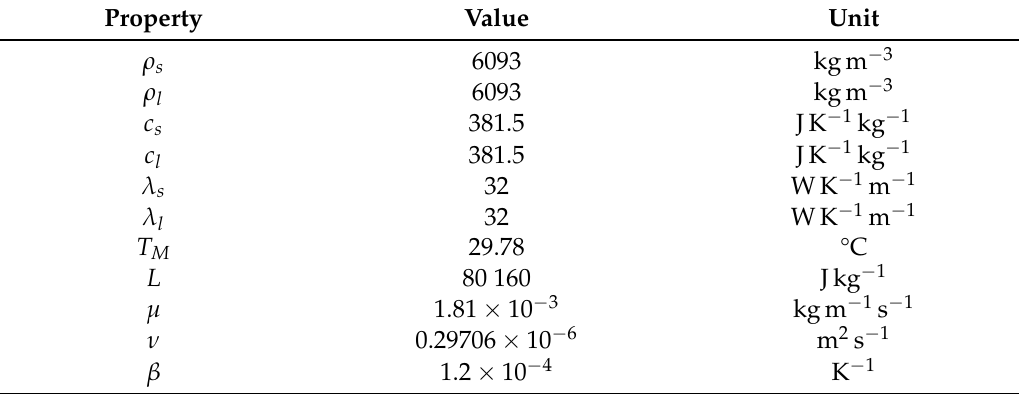
Figure 2. Sketch of the simulated experiment. Table 1. Thermophysical properties for gallium.